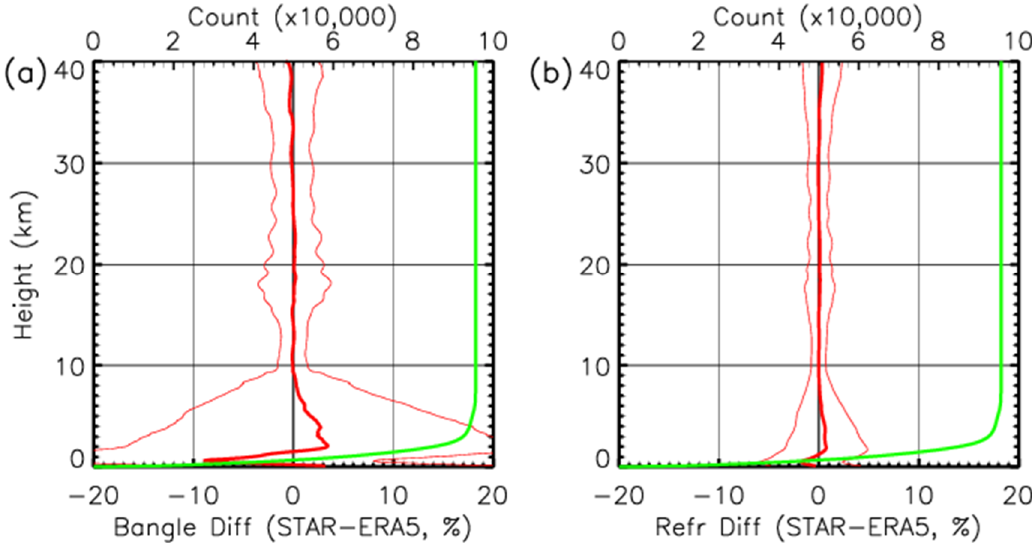
Figure 13. Fractional differences of STAR–ERA5 ( a ) bending angles and ( b ) refractivity for data from 1–31 October 2019. The thick red line represents the mean, and the thin lines represent one standard deviation from the mean. Green curves show the number of profiles used for the comparison. Table 3. Bending angle and refractivity fractional difference mean and standard deviation be- tween STAR retrievals with ERA-5 and UCAR retrievals. The standard deviations are given in parenthesis.